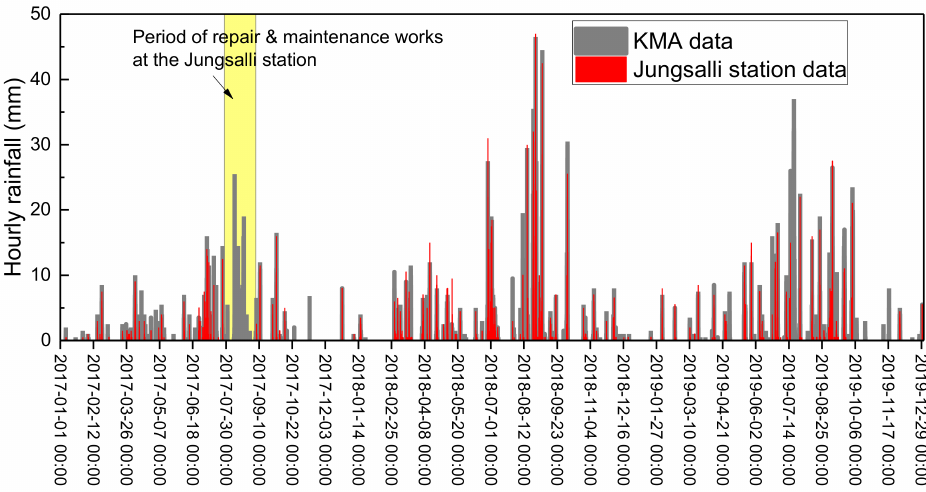
Figure 12. Comparison of the monitored rainfall data of the Jungsalli station and